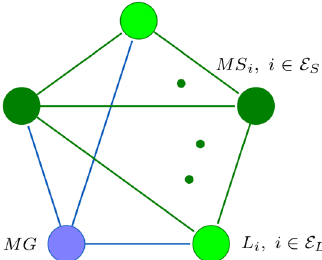
Fig. 1 An inverter-based microgrid topology ( MG : main-grid, MS : microsource, L :